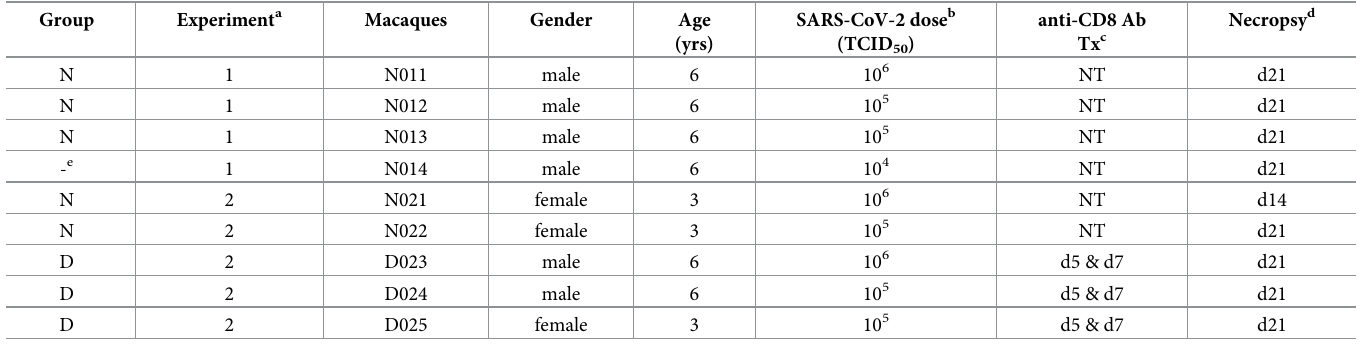
Table 1. Macaque experimental protocol.